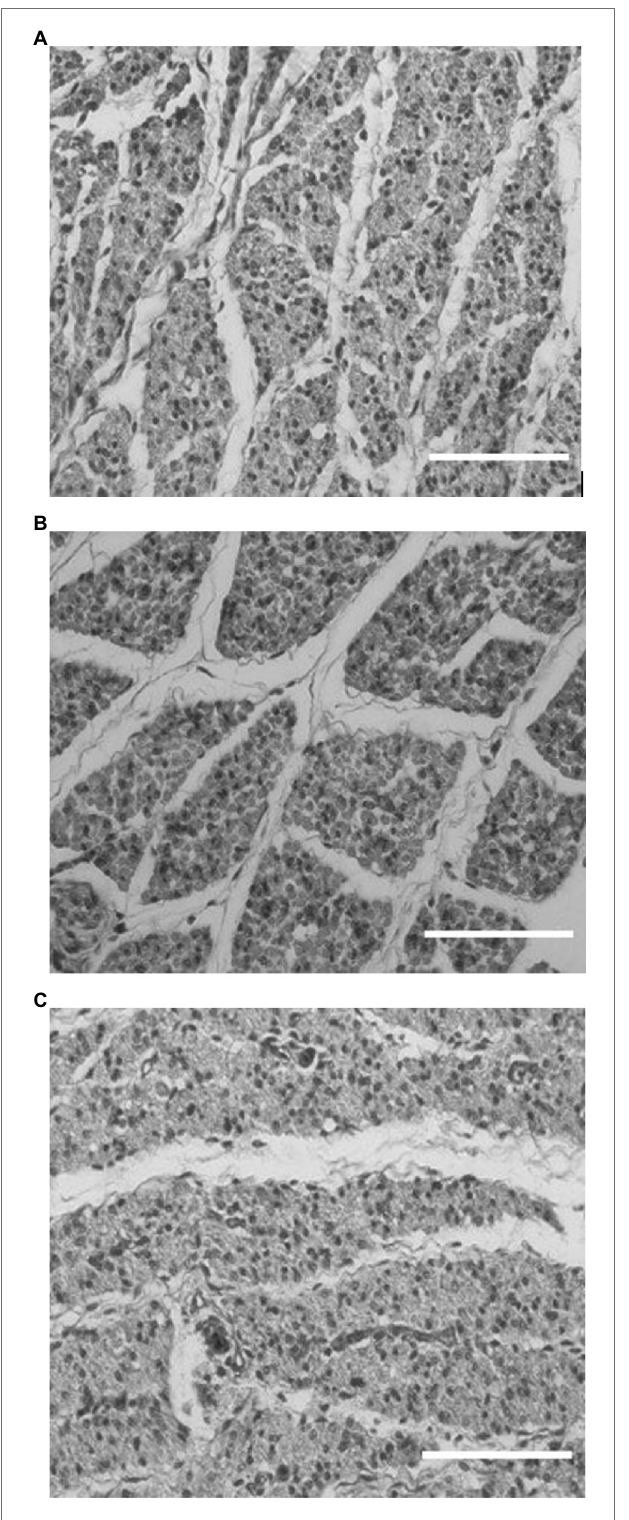
FIGURE 1 | Histology images from the RAN (A) , HBY4 (B) , and LBY4 (C) lines at embryonic day 18 under 40X magnification (Bar = 50 μ m). RAN- random bred control, BY4-high percent breast yield at 4 days post-hatch, and LBY4-low percent breast yield at 4 days